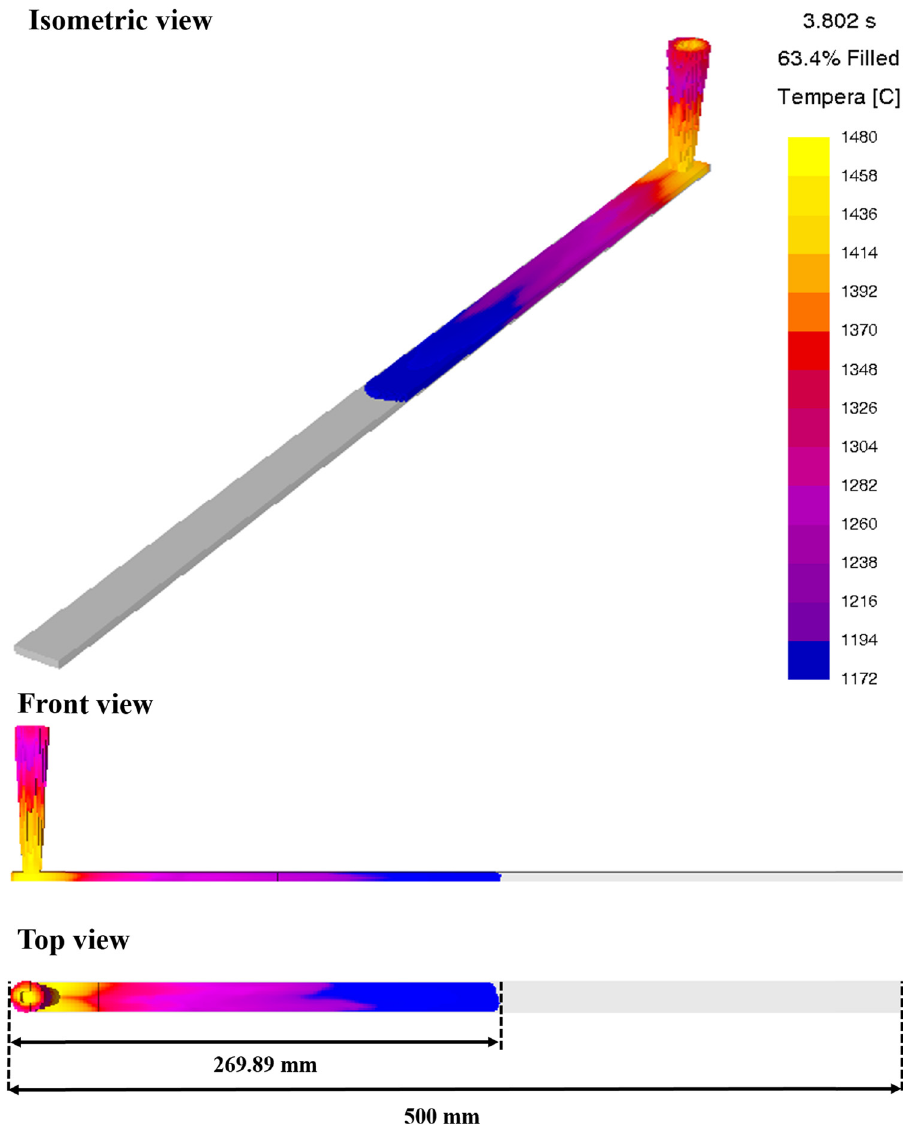
Figure 1: Simulation and measurement of the 1st